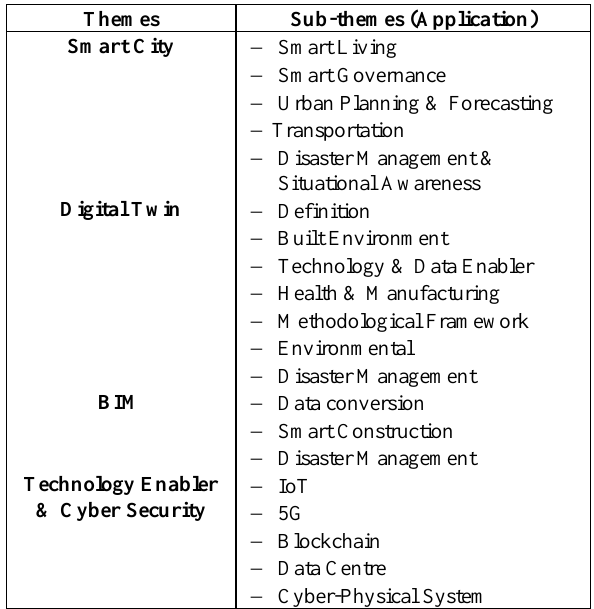
Table 2 . Thematic and Sub Thematic